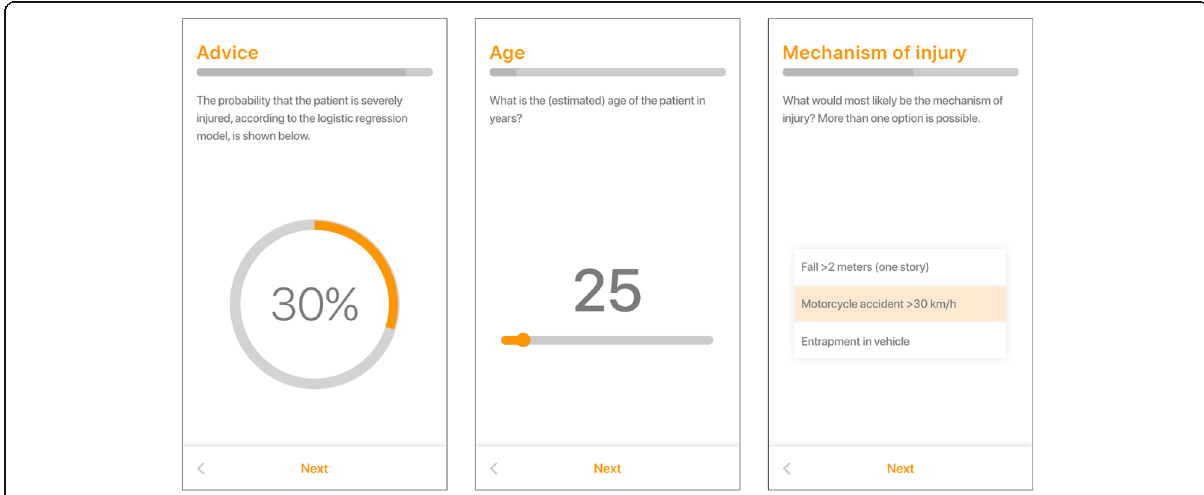
Fig. 3 The Trauma Triage App. A sample of screens from the Trauma Triage App. Left: the generated score indicating the probability that a patient might be severely injured based on all predictors. Middle: an input field requesting the age of the patient in years. Right: an input field requesting the mechanism of injury